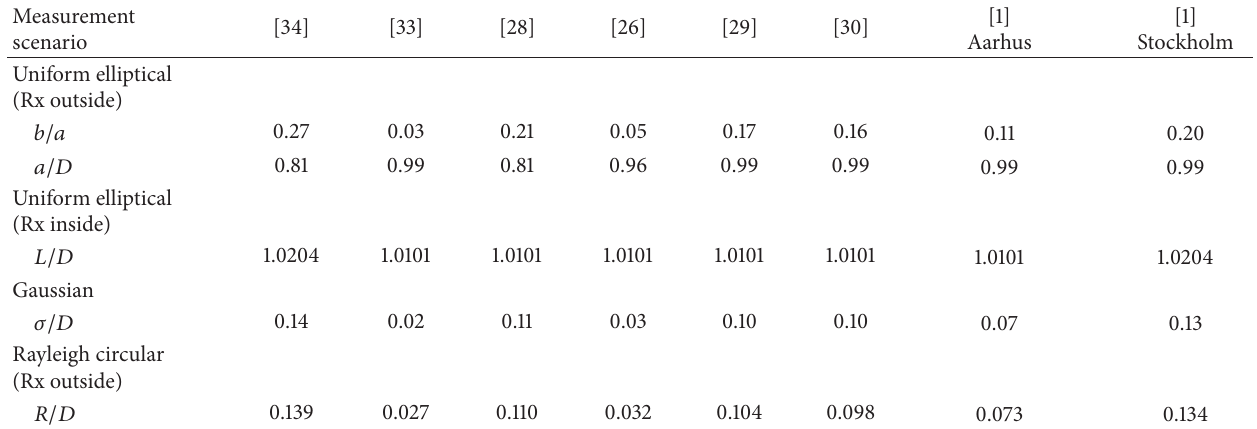
Table 5: Parameters of selected models that minimize LSE